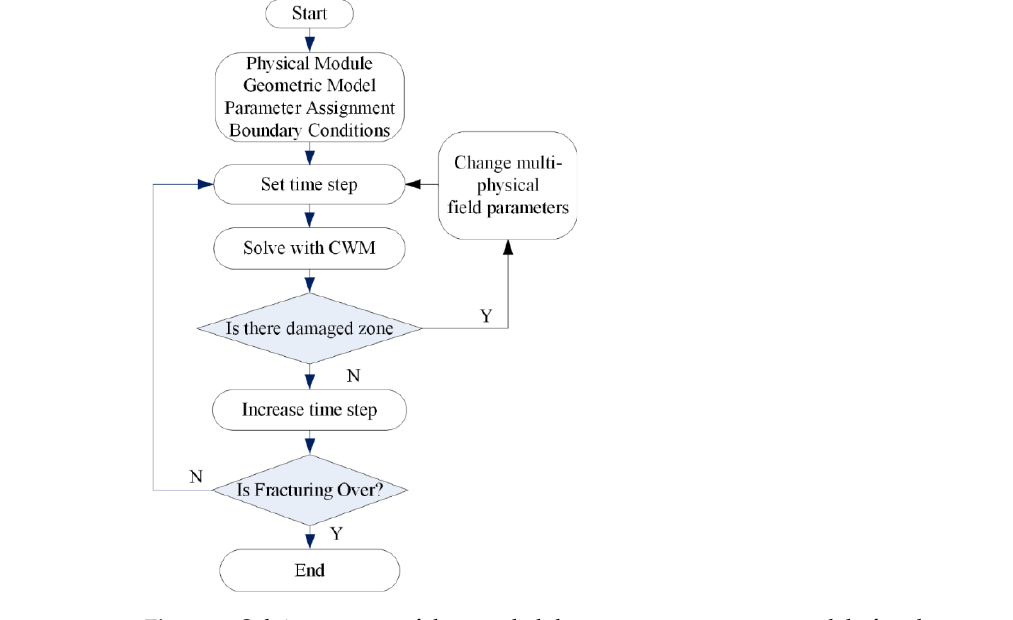
Figure 2. Solving process of the coupled damage–stress–seepage model of coal seams.